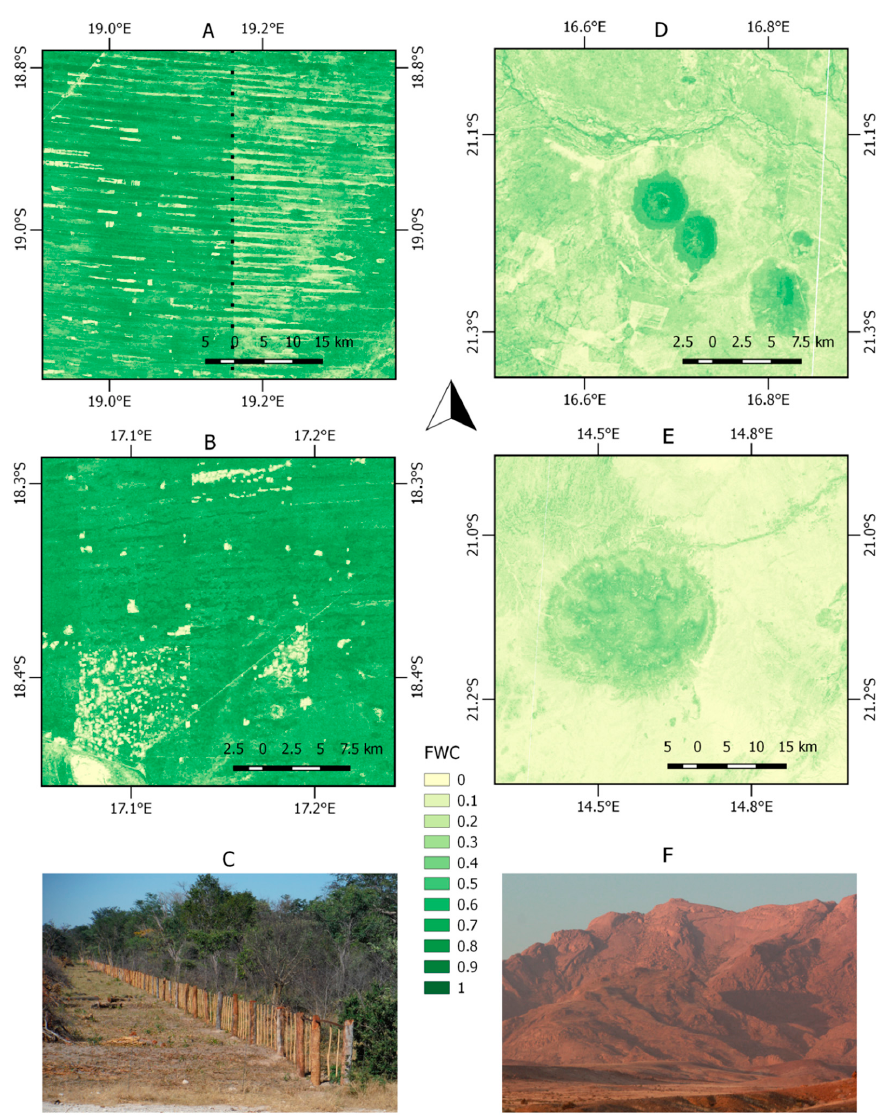
Figure 10. Examples of local fractional woody cover maps (FWC2010 50mSAR+MAP ). ( A ) Undulating patterns of FWC (south to north) caused by dunes in the North-Eastern Kalahari Woodlands. Fence-line contrast in FWC on both sides (west vs. east) of a foot-and-mouth disease veterinary fence (dashed line). ( B ) Very high FWC near the town of Oshivelo in the North-Eastern Kalahari Woodlands displaying distinct patches of debushing for charcoal production. ( C ) Debushing for charcoal production and subsistence cultivation. ( D ) Correct estimation of FWC on steep slopes of hills south of Otjiwarongo. ( E ) Overestimation of FWC on steep, barren slopes of ( F ) the Brandberg. Distinct patches of low FWC ( < 0.1) were caused by debushing for the production of charcoal in the dense (0.55–0.75 FWC) North-Eastern Kalahari Woodlands (Figure 10B). An overestimation of FWC ◦ was sometimes caused by high backscatter from the steep slopes ( > 20 ) of the mountains and hills